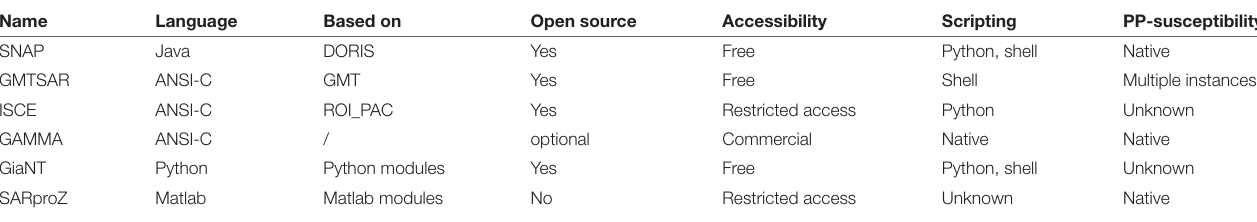
TABLE 1 | Overview of SAR software